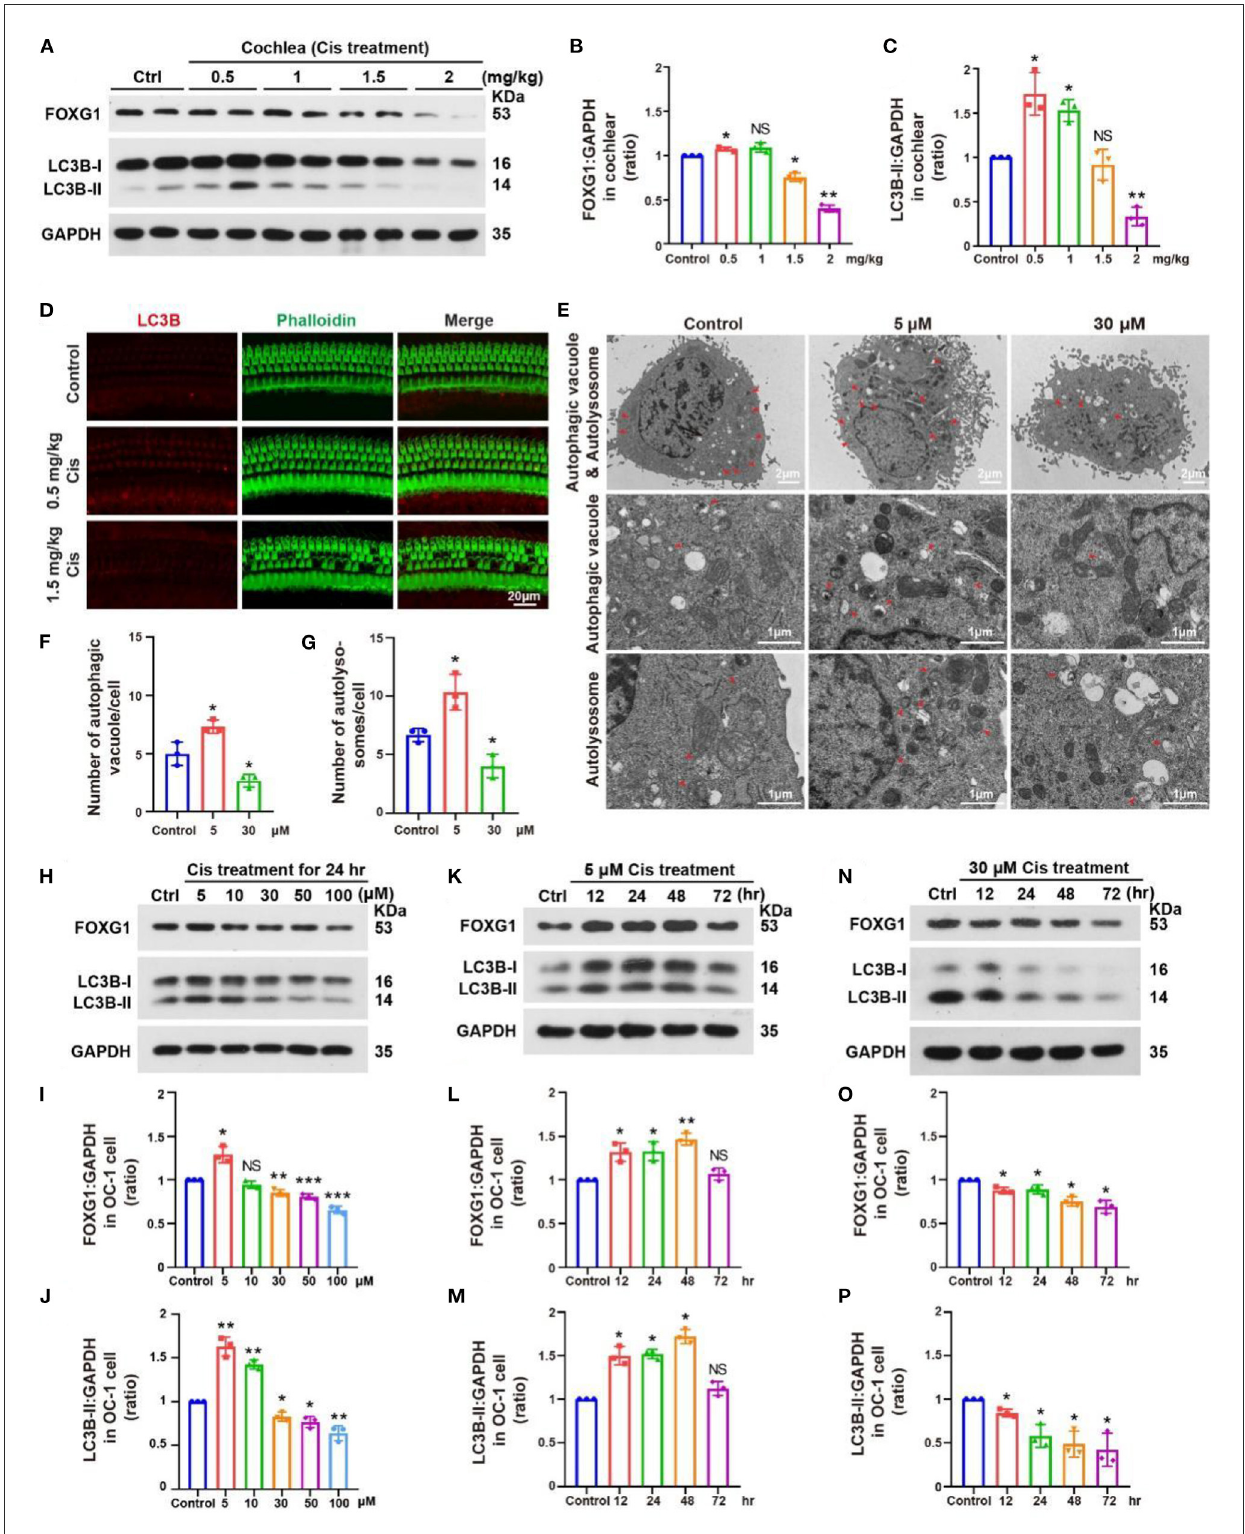
FIGURE4 Changes in FOXG1 and autophagy levels in the cochlea and OC-1 cells after cisplatin treatment. (A) Western blotting of changes in FOXG1 and LC3B levels in the cochlea after treatment with different cisplatin concentrations. (B, C) Quantification of the western blotting in (A) . (D) Immunofluorescence staining for LC3B and phalloidin in the cochlea after cisplatin treatment. (E) TEM of changes in autophagic vacuoles and autolysosomes after treatment with 5 or 30 µ M cisplatin for 24h. (F) Quantification of the autophagic vacuoles changes in (E) . (G) Quantification of the autolysosomes changes in (E) . (H) Western blotting of changes in FOXG1 and LC3B levels after treatment with different cisplatin concentrations for 24h. (I, J) Quantification of the western blotting in (H) . (K) Western blotting of changes in FOXG1 and LC3B levels after treatment with 5 µ M cisplatin for different times. (L, M) Quantification of the western blotting in (K) . (N) Western blotting of changes in FOXG1 and LC3B levels after treatment with 30 µ M cisplatin for different times. (O, P) Quantification of the western blotting in (N) . * p < 0.05, ** p < 0.01, *** p <